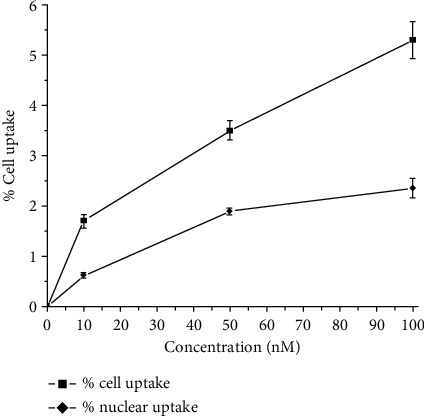
Cellular and nuclear uptakes of 177Lu-acridine in Raji cells at different concentrations.